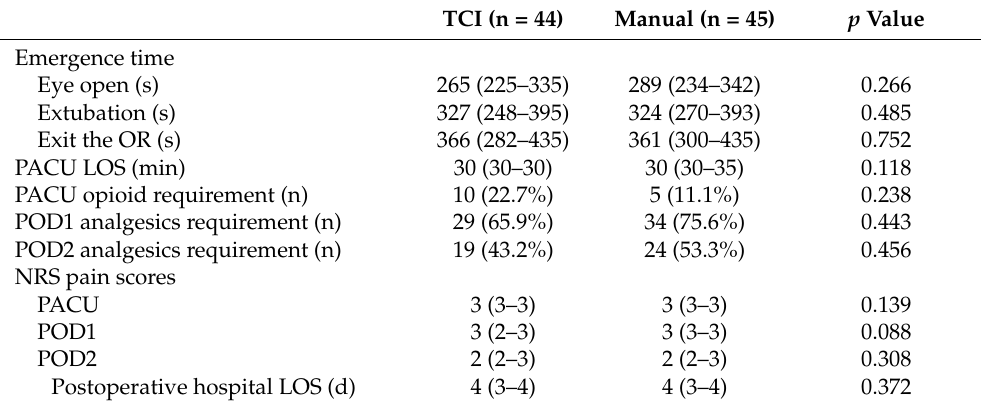
Table 2. Postoperative secondary